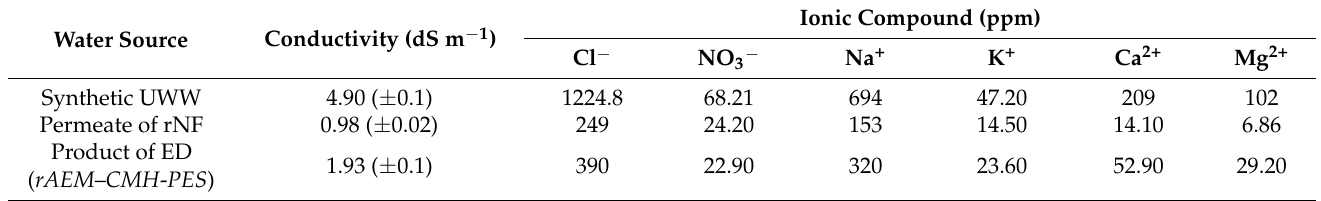
Table 2. Characteristics of the synthetic solution and the effluents of NF and ED